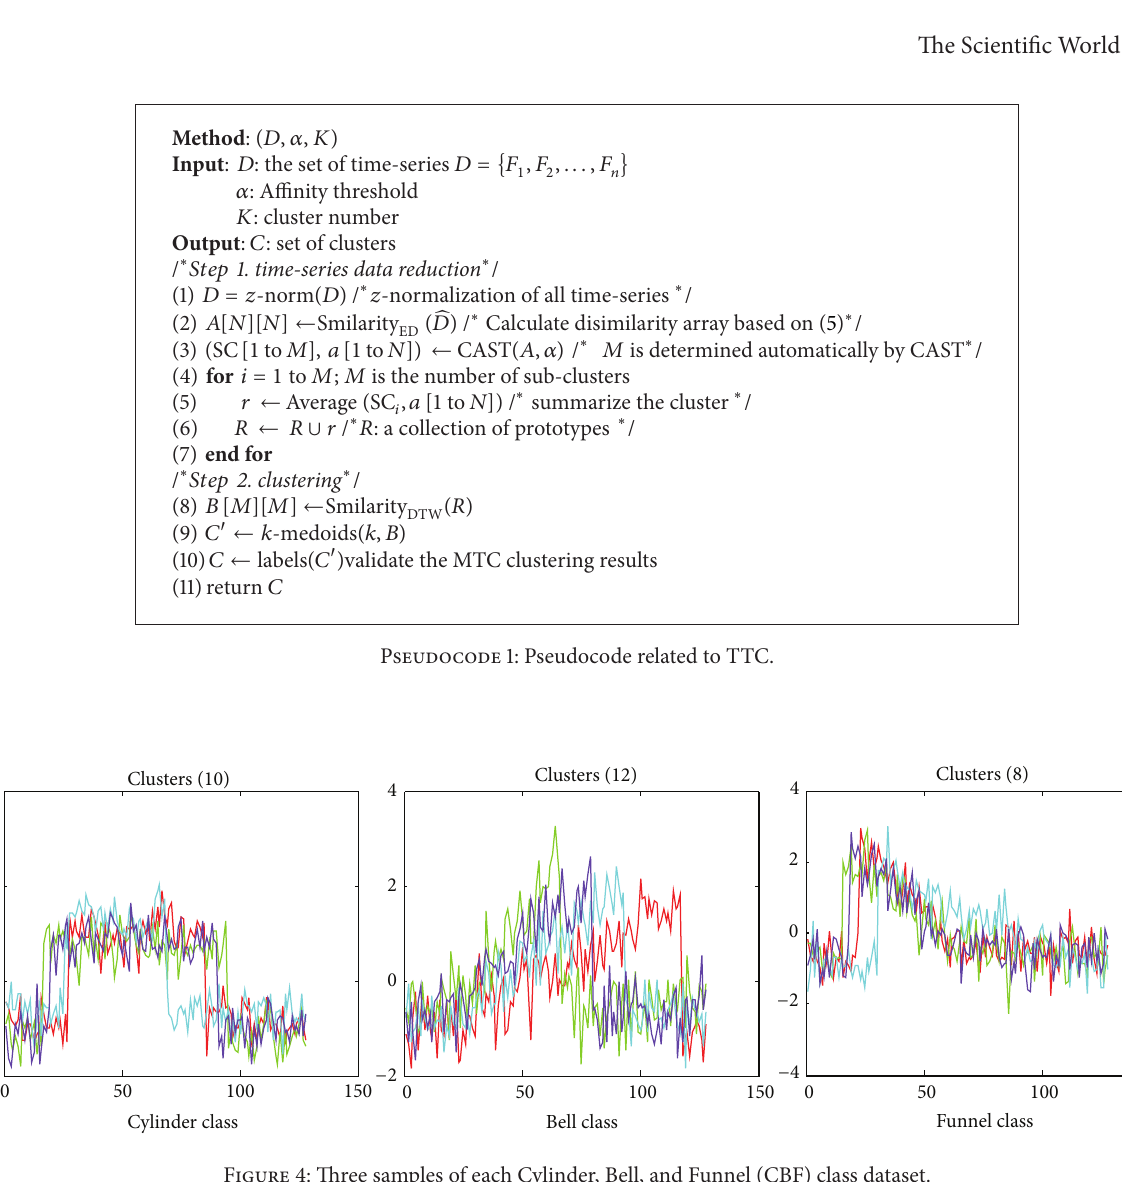
Figure 4: Three samples of each Cylinder, Bell, and Funnel (CBF) class